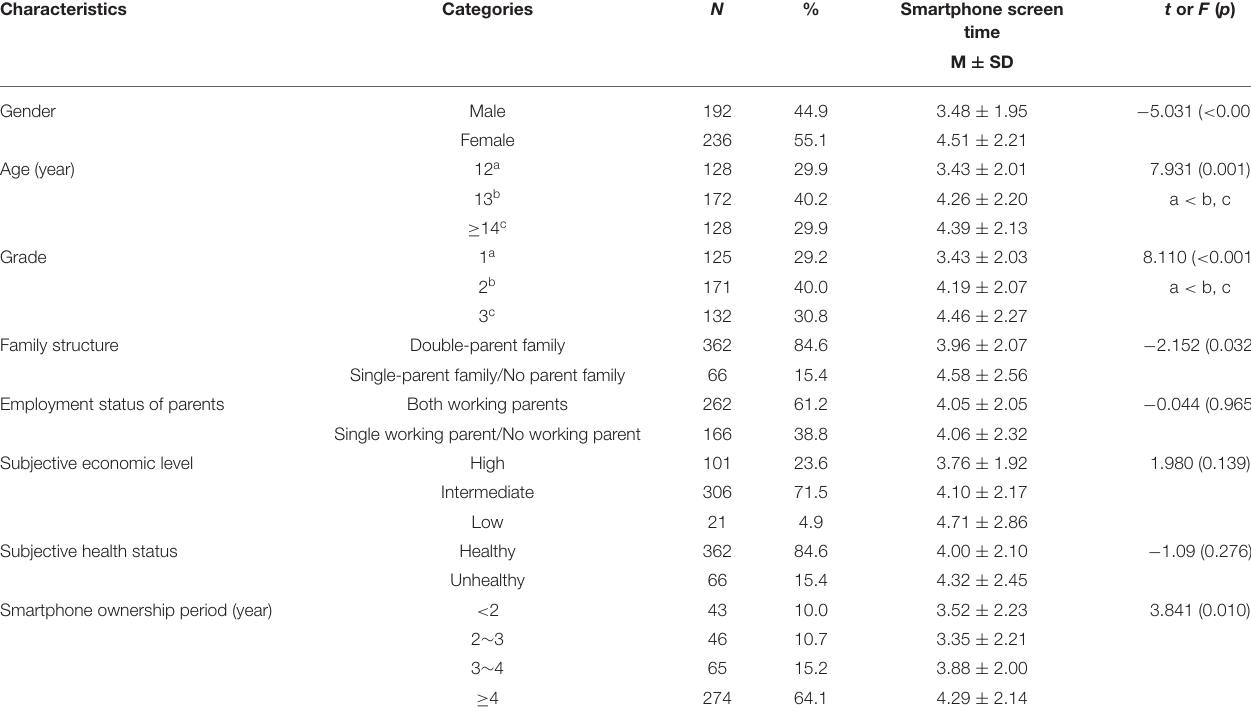
TABLE 1 | Smartphone screen time by socio-demographic characteristics ( N = 428).